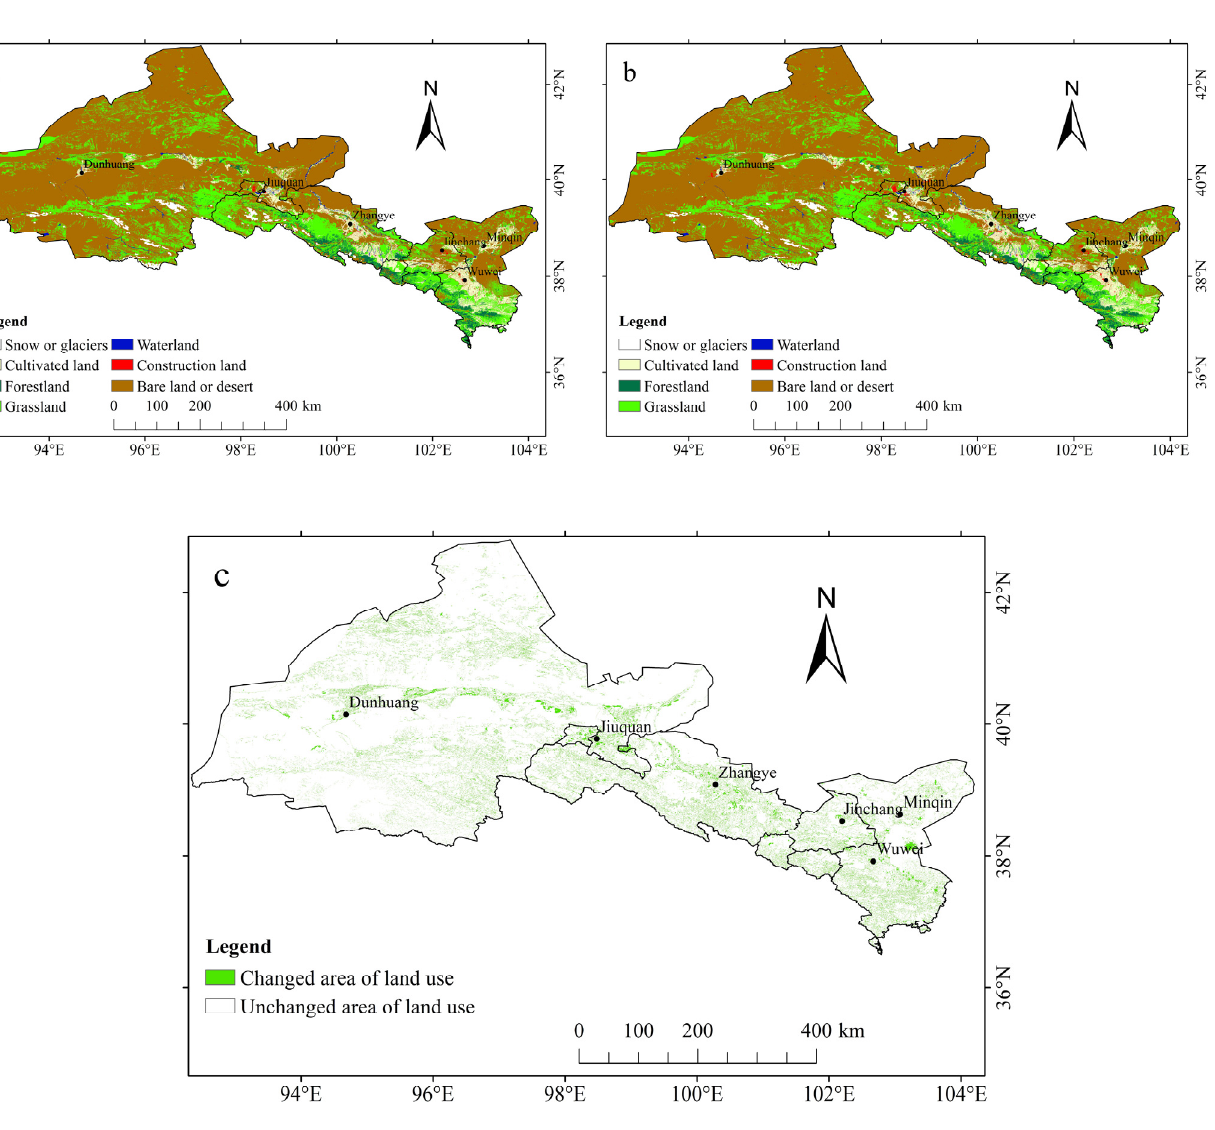
Figure 3. Land use in the Hexi Corridor: ( a ) 2000, ( b ) 2020 and ( c ) changed area